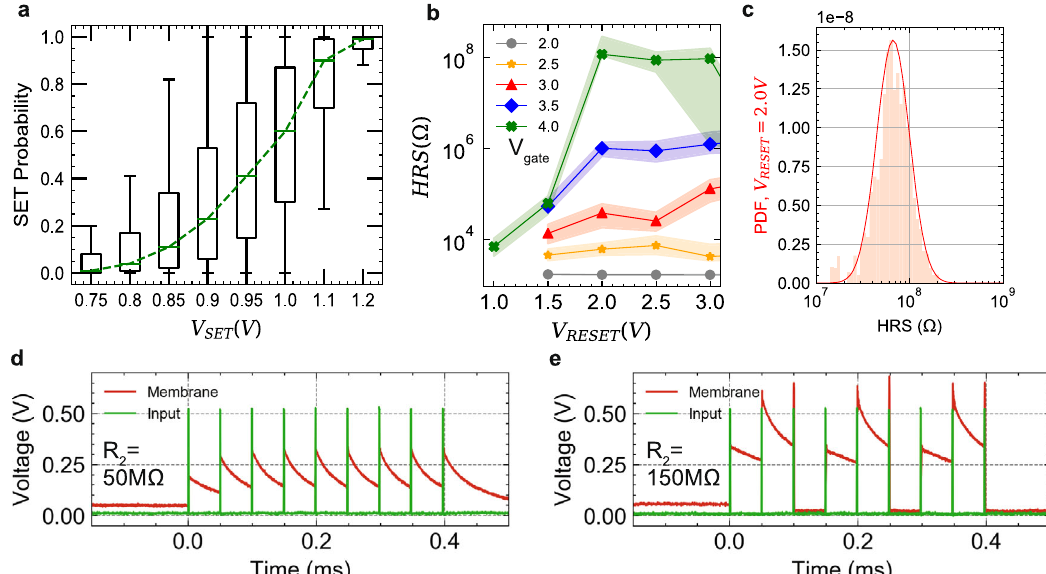
Fig. 2 | Measurements from our fabricated synapse and neurons of Fig. 1 in 130nmtechnologyintegratedwithHfO 2 -basedRRAM.a – c Experimentalresults from the fabricated 4kb synapse array, each device is programmed 100 times. a SET characteristics; The box plot represents the SET probability as a function of theSETvoltage,overtheRRAMpopulation;thegreenhorizontalbarrepresentsthe medianvalue,theboxlowerandupperlimitsrepresentthe±25%and±75%quartile respectively, and the whiskers show the±95% quartile. The dashed green line connecting the median values shows the emerging sigmoidal behavior of the SET probability over the SET voltage. b RESET characteristics; HRS measurements as a functionoftheRESETvoltageappliedacrossthedevices( V RESET ),fordifferentgate